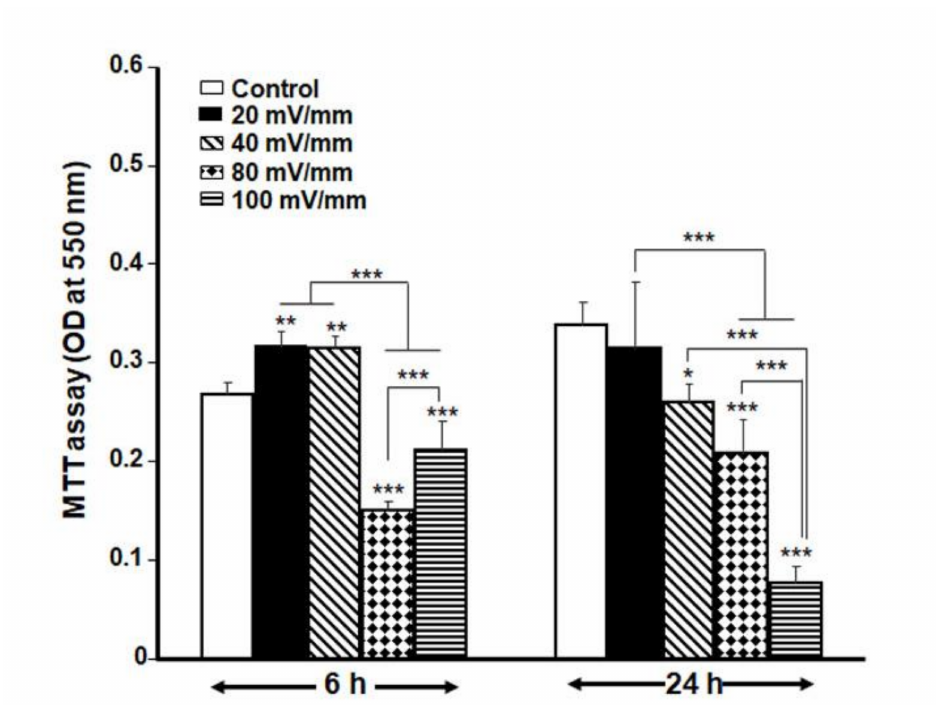
Figure 3. Selection of non-toxic ES intensities for DHSF exposed for 6 or 24 h to ES at various intensities. The cells were cultured for an additional 48 h without ES prior to MTT assay. Data are presented as means ± SD ( n = 4). * p < 0.05, ** p < 0.01, *** p < 0.001. The control (no ES) and ES-exposed cells were compared, as well as the different ES intensities.